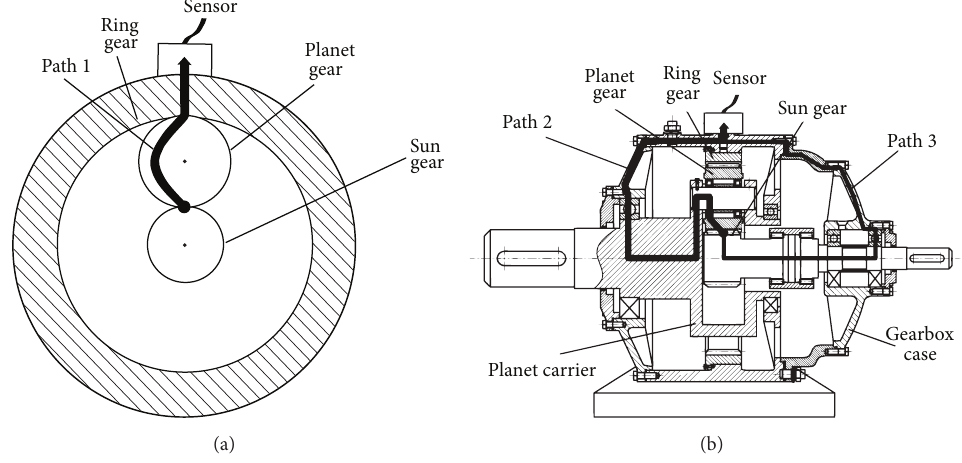
Figure 3: Propagation paths of signal. (a) Path 1; (b) path 2 and path 3.